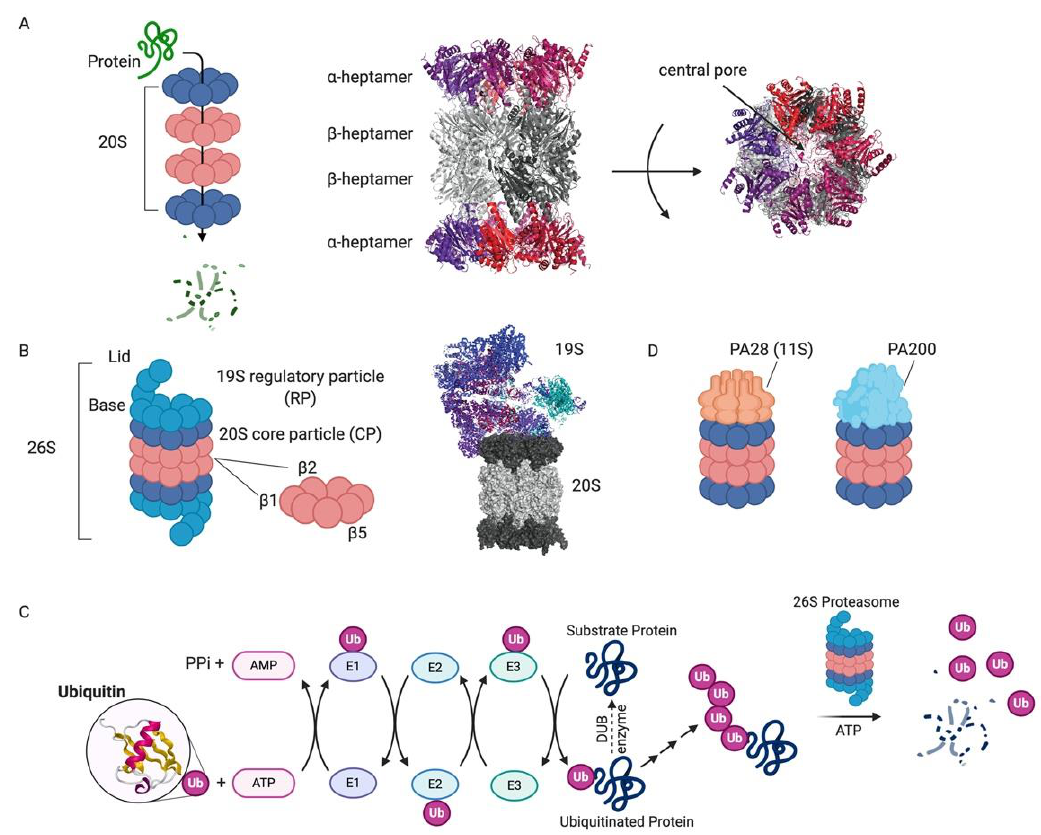
Figure 1. Proteasome and ubiquitin-mediated degradation [85]. ( A ) Schematic of substrate protein degradation by passage through the central pore of the four stacked heptameric rings that comprise the 20S proteasome (left) . The X-ray crystal structure of the yeast 20S proteasome (PDB 1RYP) shows the two capping α -heptameric rings (red / violet) and the middle two β -heptamers (grey; middle) . The central pore through which substrates are threaded is indicated in the top view (right) . ( B ) The 26S proteasome is the central component of the UPS. A cartoon depiction of the components of the 26S proteasome highlights the lid and base of the 19S RP in addition to the DUB Rpn11 and the catalytic β -rings (left) . The cryo-EM structure of the human 26S proteasome (PDB 6MSB) shows the structure of the 26S proteasome in a state competent for ubiquitinated substrate engagement. ( C ) Schematic of the ubiquitin-proteasome system (ubiquitin PDB 1UBQ). ( D ) Schematic of alternative 20S proteasome complexes with a heptameric PA28 cap or a monomeric PA200